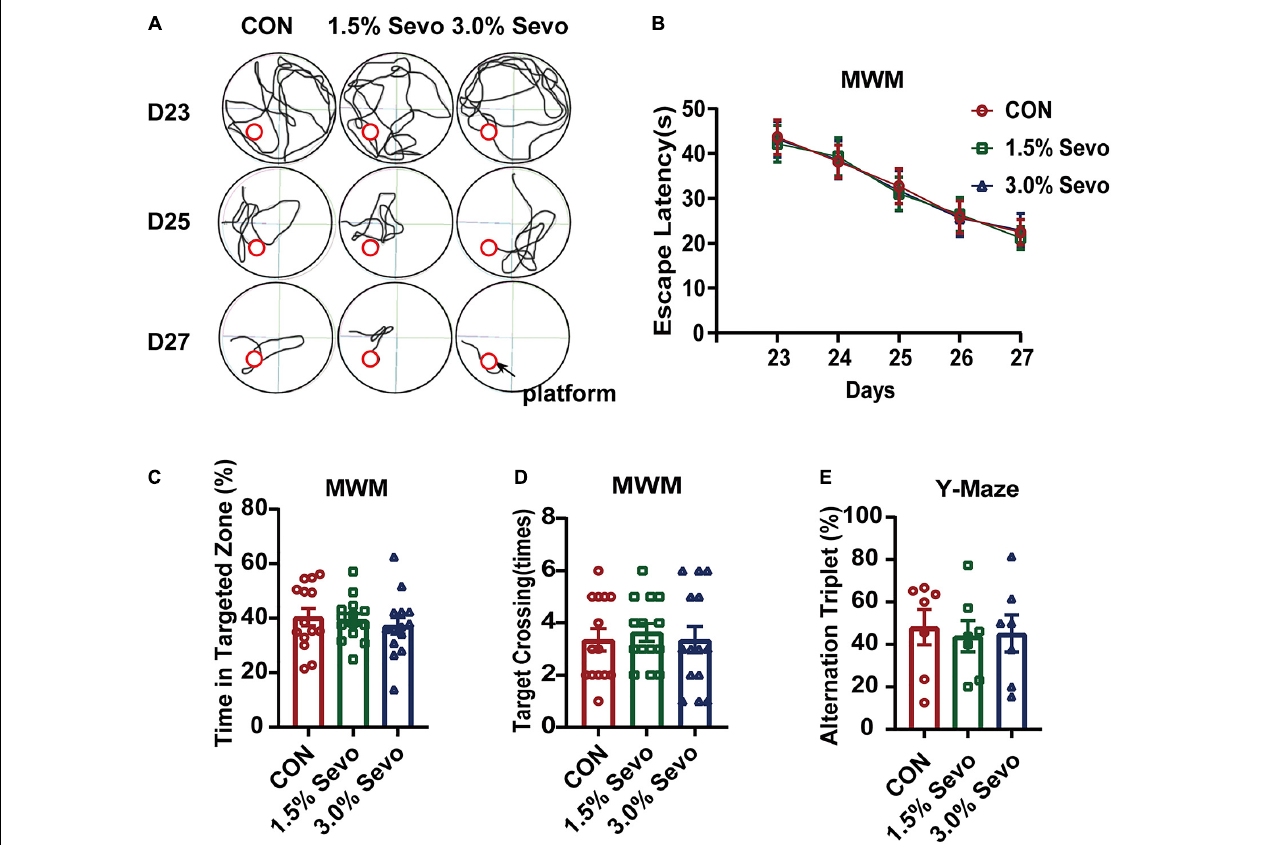
FIGURE 2 | Exposure to 1.5 or 3% sevoflurane does not induce cognitive impairment in adult mice. (A) Representative tracks and (B) escape latency of the MWM during training days. The platform is located in circle region. (C) The percentage of time in targeted zone in testing day. (D) Times of target crossing. (E) Alternation triplet of Y-maze. Values are the mean ± S.E.M ( n = 7/group). D, days of experimental procedure; MWM, Morris Water Maze Test; CON, control group; 1.5% Sevo, 1.5% sevoflurane group; 3.0% Sevo, 3.0% sevoflurane